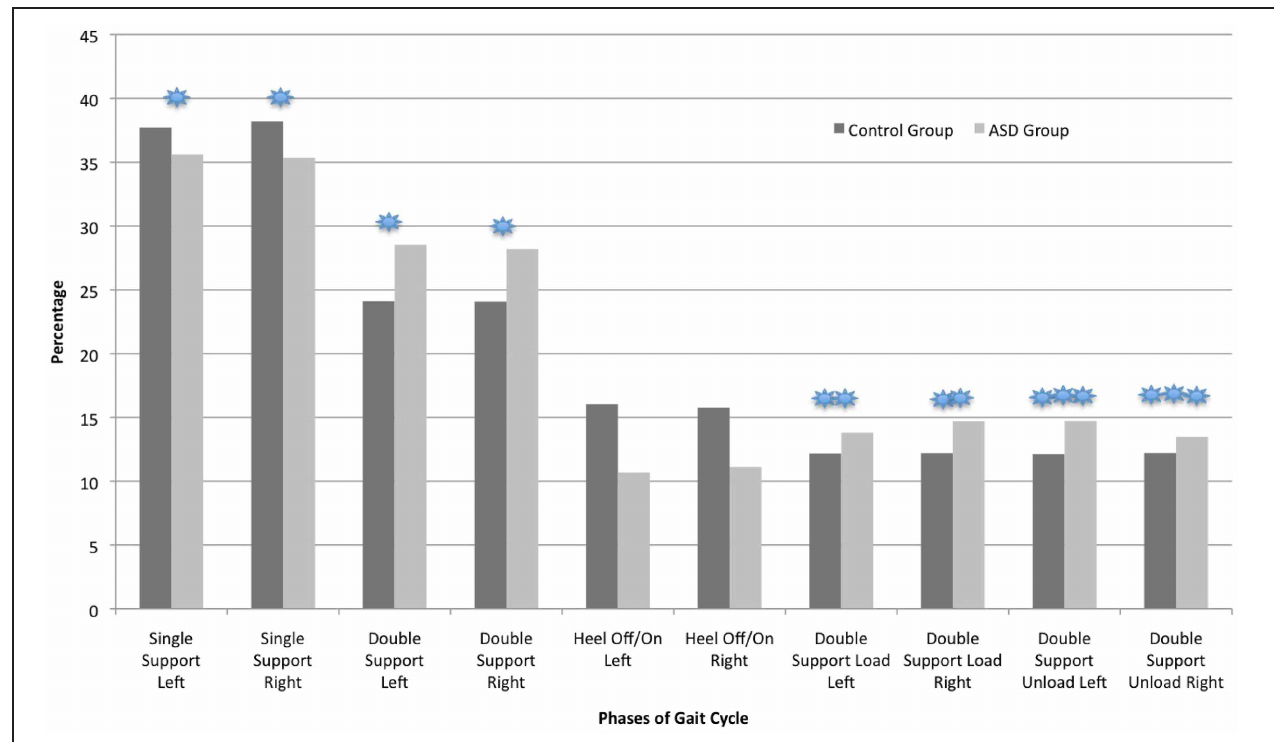
FIGURE 3 | Comparison of the two groups in the percentage of time spent in each Gait Cycle phase. p < 0 . 001 ( ); p < 0 . 003 ( ); p < 0 .